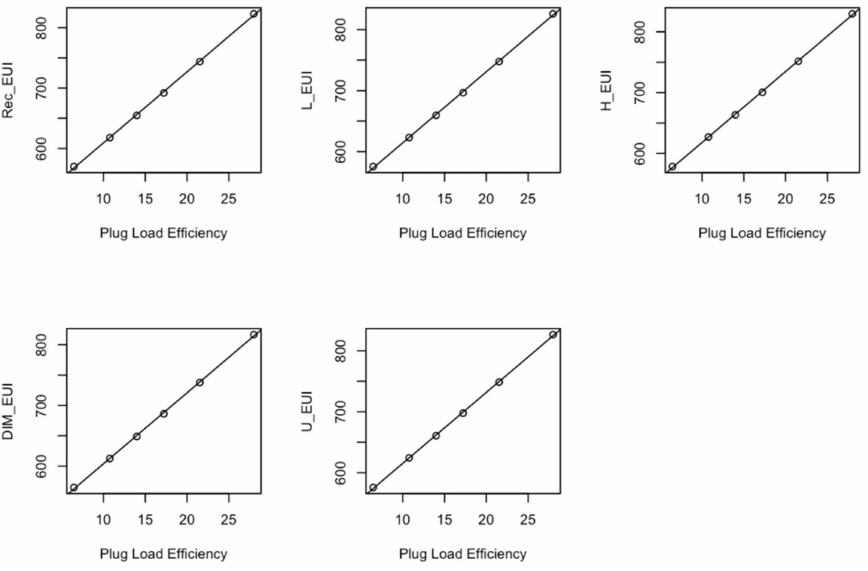
Figure 14. Plug load efficiency fitted line